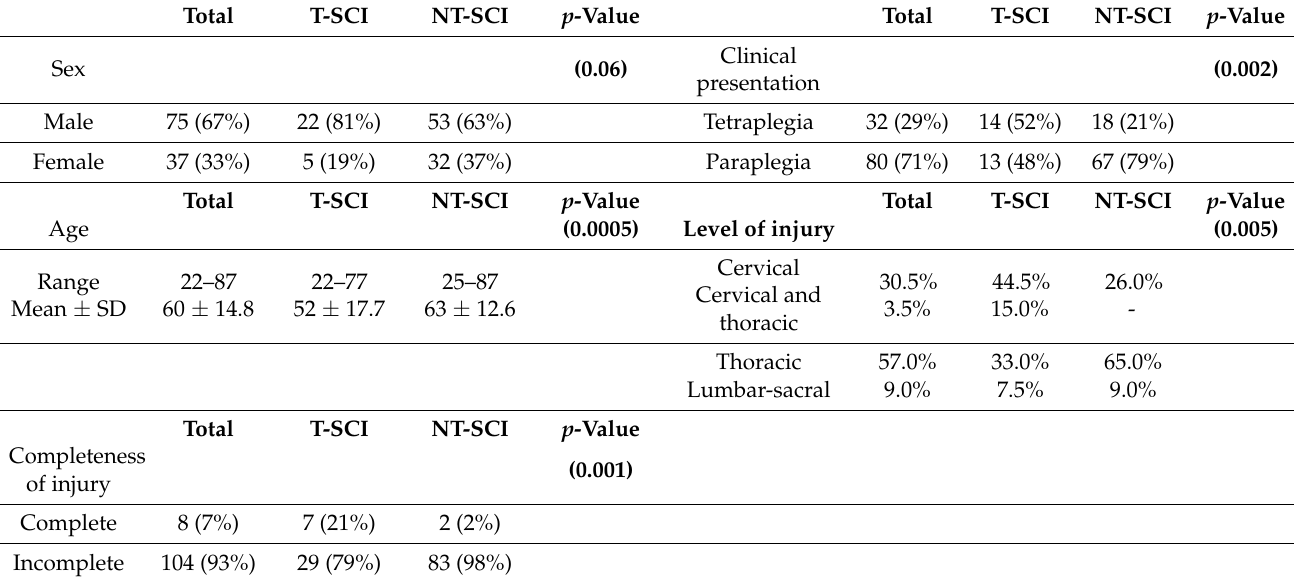
Table 1. Demographic, clinical, and neurological features of traumatic and nontraumatic SCI. Adopted with permission From the American Association of Neurological Surgeons (AANS); Amer- ican Society of Neuroradiology (ASNR); Cardiovascular and Interventional Radiology Society of Europe (CIRSE); Cannadian International Radiology Assciation (CIRA); Congress of Neurological Surgeons (CNS); European Society of Minimally Invasive Neurological Therapy (ESMINT); European Society of Neuroradiology (ESNR); European Stroke Organization (ESO); Society for NeuroInter- ventional Surgery (SNIS); World Stroke Organization(WSO); et al. Multisociety Consensus Quality Improvement Revised Consensus Statement for Endovascular Therapy of Acute Ischemic